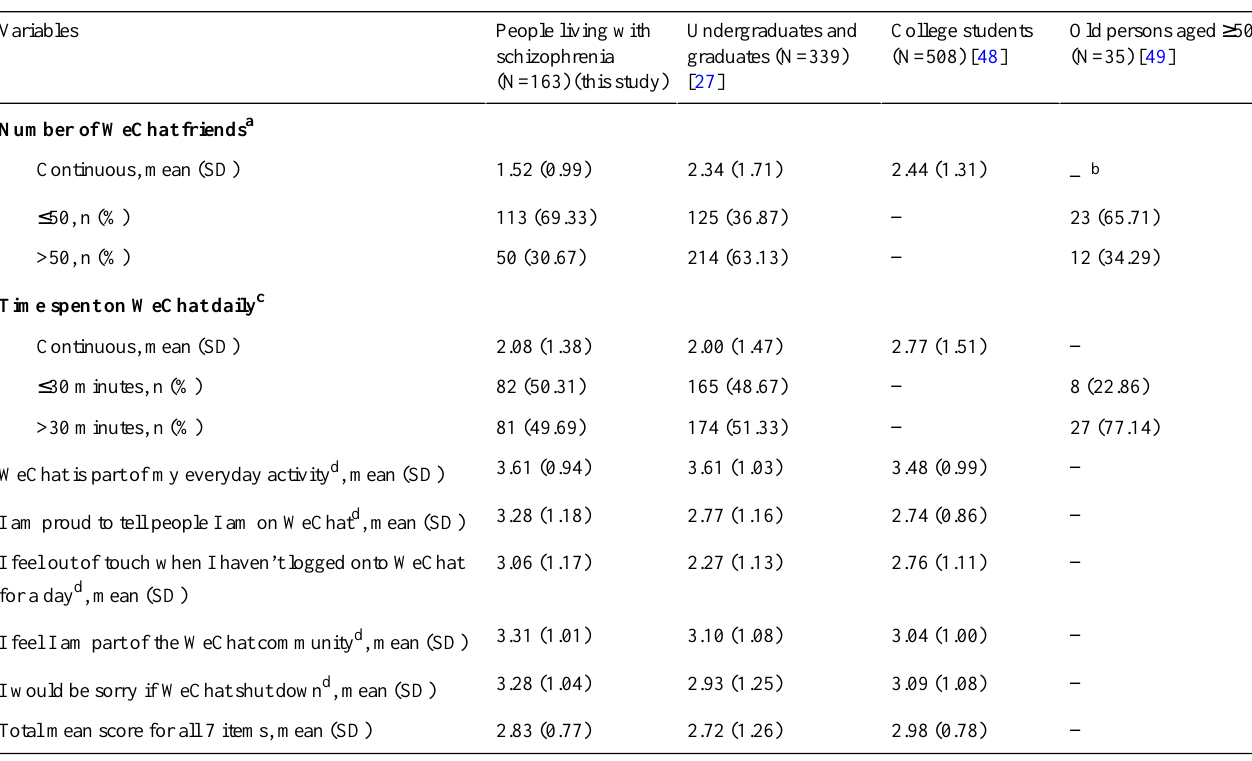
Table 1. Summary statistics for WeChat intensity score and comparison with other